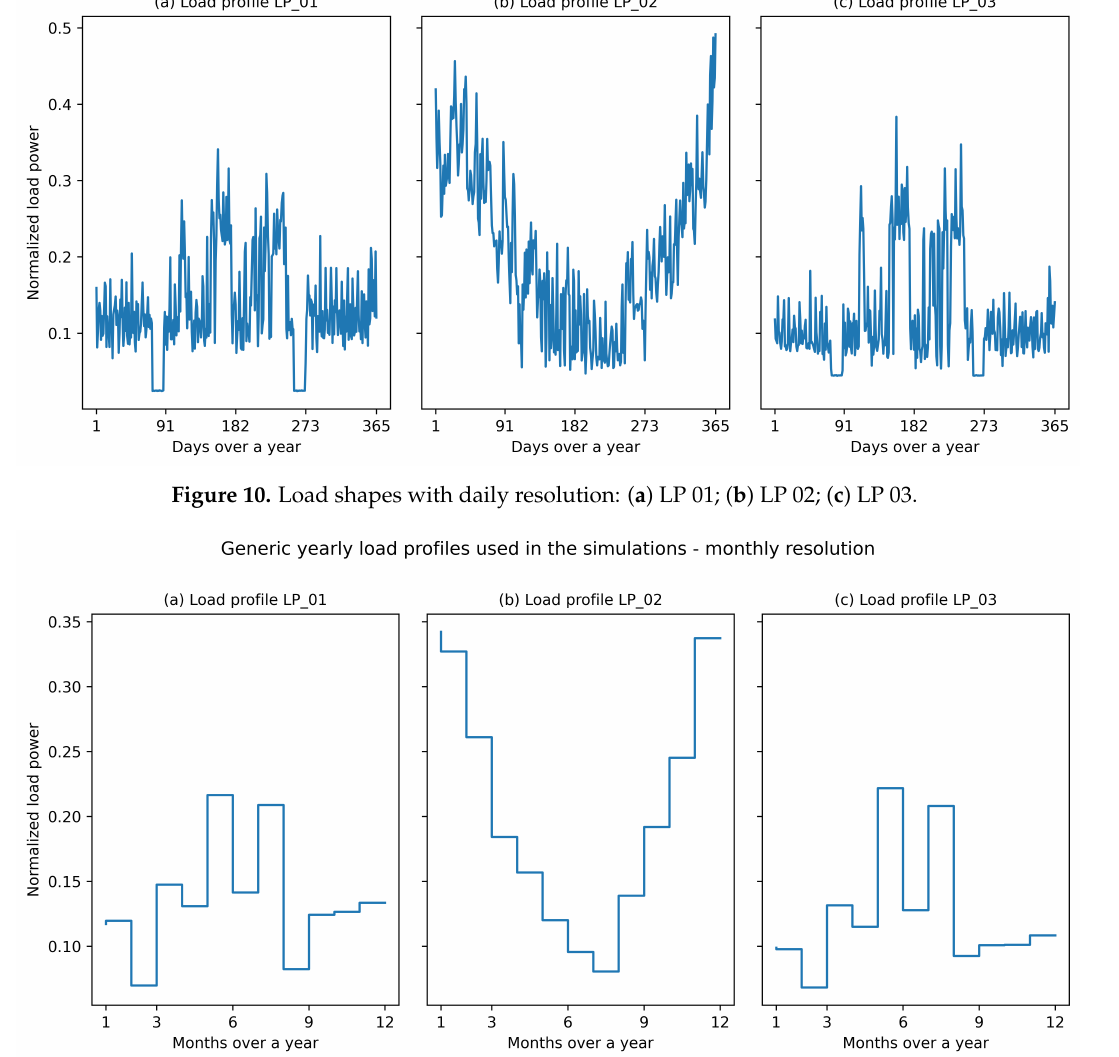
Figure 11. Load shapes with monthly resolution: ( a ) LP 01; ( b ) LP 02; ( c ) LP 03.